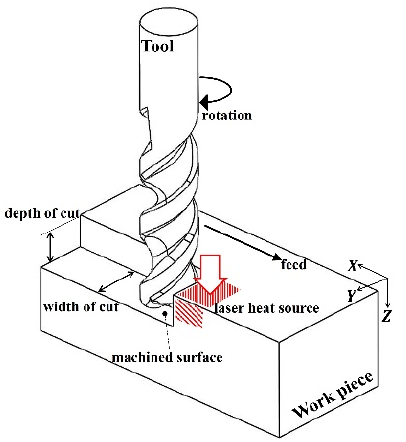
Figure 2. Schematic diagram of laser ‐ assisted end milling process.